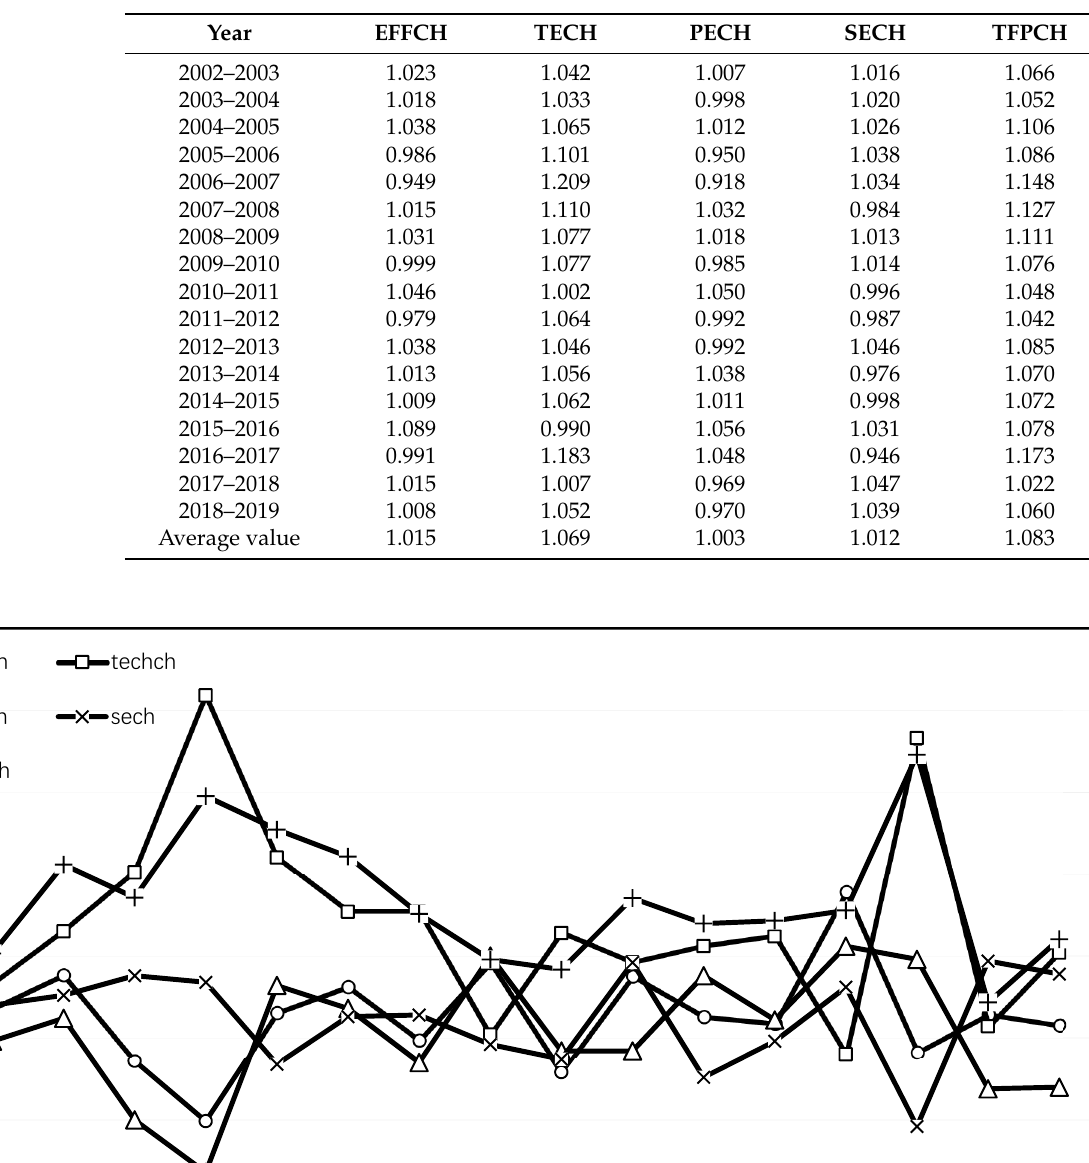
Table 6. Economic efficiency index of UCL in BTH region by annual changes and its decomposition index.